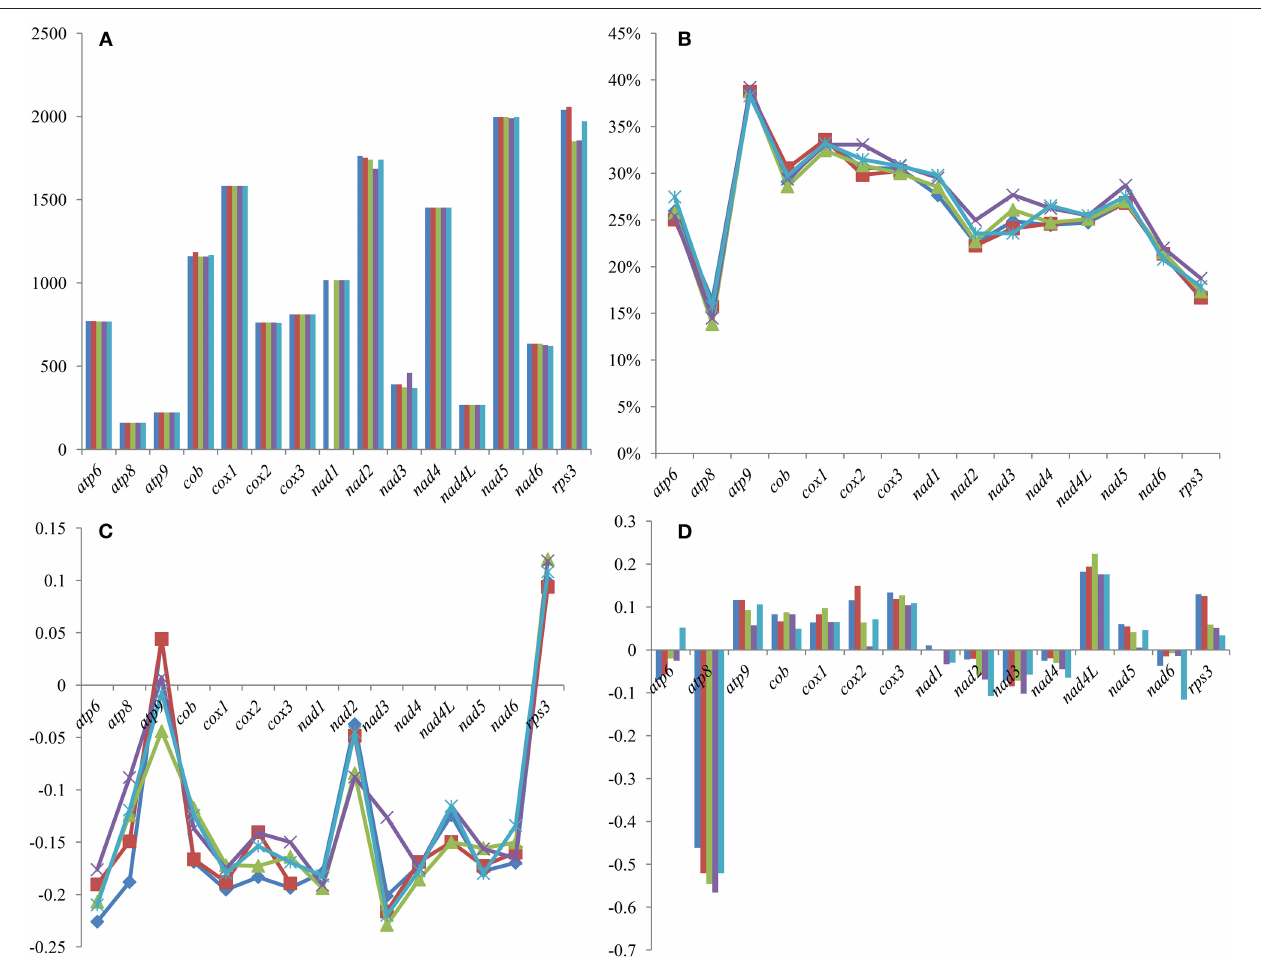
FIGURE 4 | Variation in the length and base composition of 15 protein-coding genes (PCGs) between the five Tricholoma mitogenomes. (A) PCG length variation; (B) GC content of the PCGs; (C) AT skew; and (D) GC